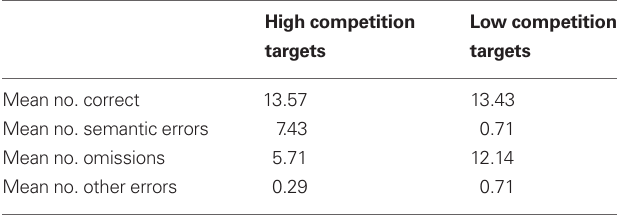
Table 2 | Mean numbers of correct responses and errors in Experiment